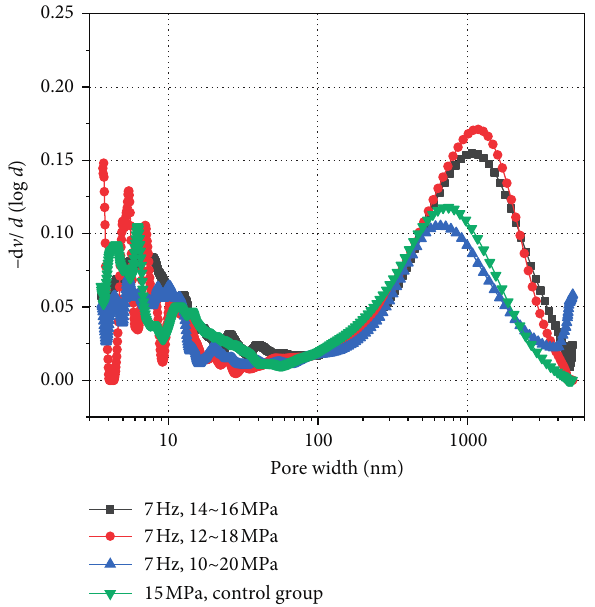
Figure 9: Distribution density functions of the pore volumes at different loading